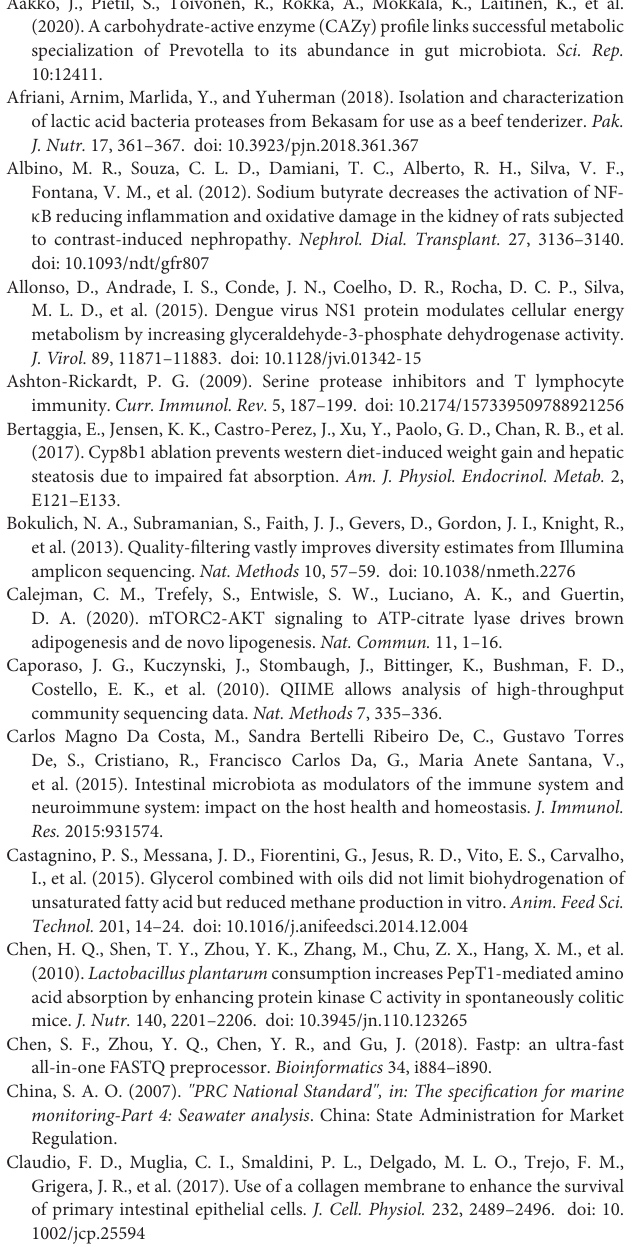
Supplementary Figure 5 | Volcano plots of the DEGs in the distal intestine of hybrid grouper. (A) FMb vs. bL. (B) FMb vs. bH. (C) bH vs. bHNaB. Supplementary Figure 6 | Comparison of the RT-PCR and RNA Seq results. Supplementary Figure 7 | The LC-MS spectra of the distal intestine contents in positive (A) and negative (B) modes. Supplementary Figure 8 | Partial least squares discriminant analysis (PLS-DA) plot of distal intestinal of the FMb and bL following positive (A1,A2) and negative (A3,A4) ions; FMb and bH following positive (B1,B2) and negative (B3,B4) ions; bH and bHNaB following positive (C1,C2) and negative (C3,C4) ions.